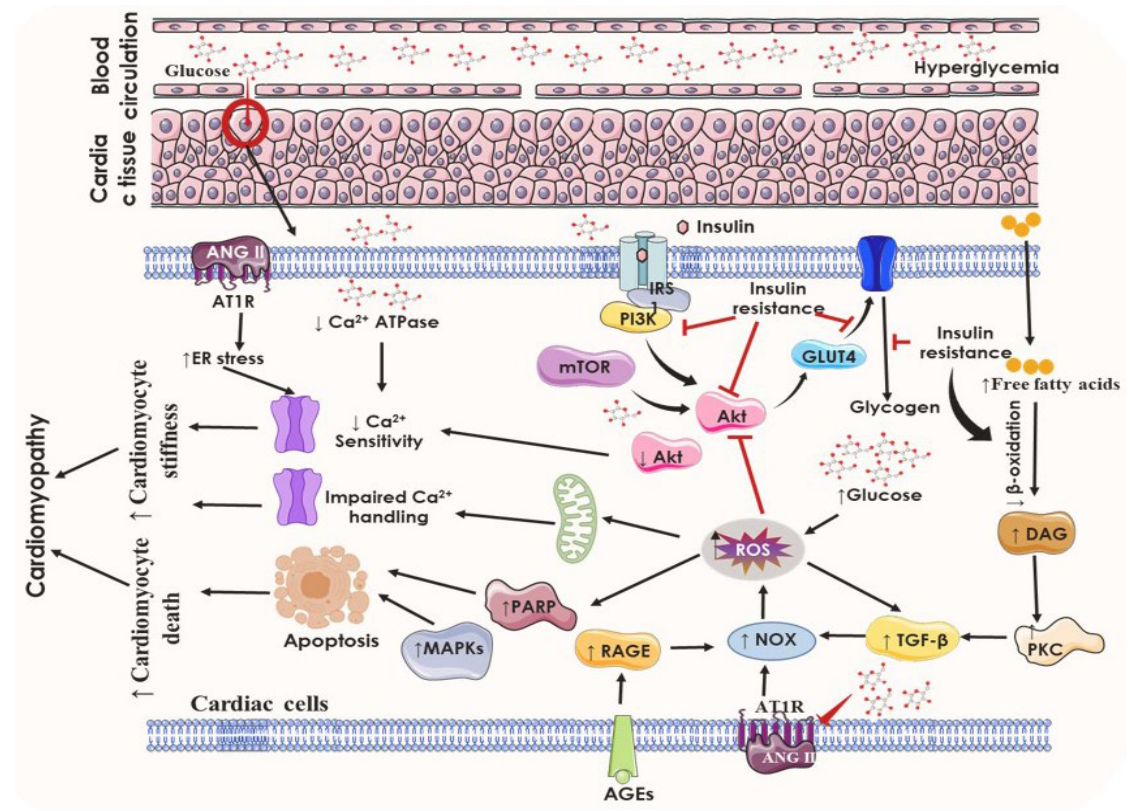
Figure 6. Overall pathophysiological anomalies underlying diabetic cardiomyopathy. Black arrows represent downstream events and red lines represent suppression. AGEs, advanced glycation end products; AGT II, angiotensin II; ATP, adenosine triphosphate; BNP, brain-derived natriuretic peptide; DAG, diacyl glycerol; ER stress, endoplasmic reticulum stress; GLUT, glucose transporters; IRS-1, insulin receptor substrate 1; MAPK, mitogen-activated protein kinases; mTOR, mammalian target of rapamycin; PARP, poly (ADP-ribose) polymerase enzymes; PI3K, phosphoinositide 3-kinases; PKC, protein kinase C; RAGEs, receptor for advanced glycation end products; ROS, reactive oxygen species; TGF, transforming growth factor.